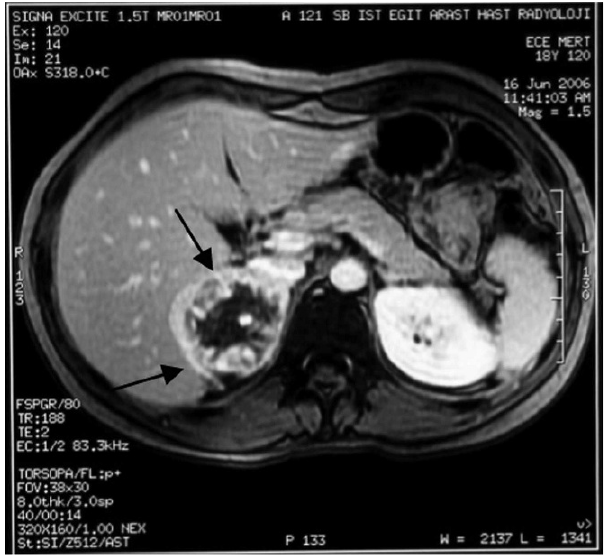
Figure 1 - Hyperintense and heterogeneous right adrenal mass (arrow) on a T2-weighted MRI